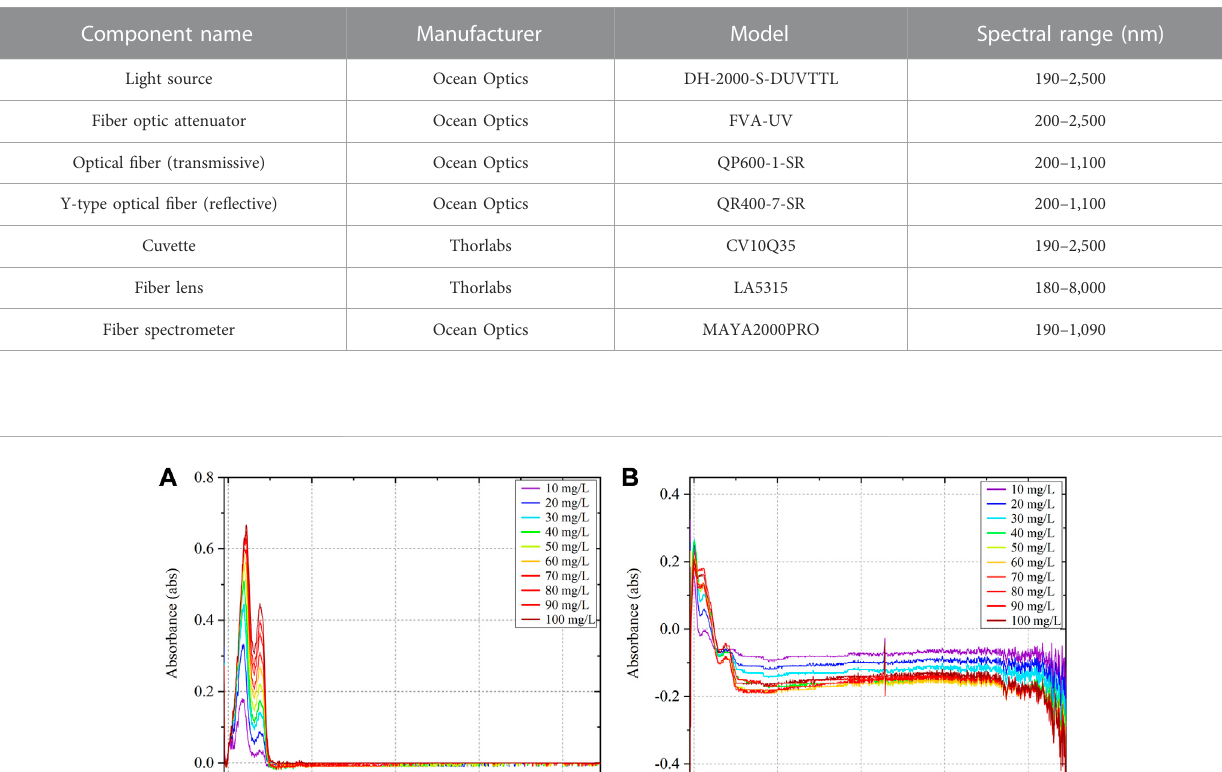
TABLE 2 The manufacturer, model and spectral range of each component.